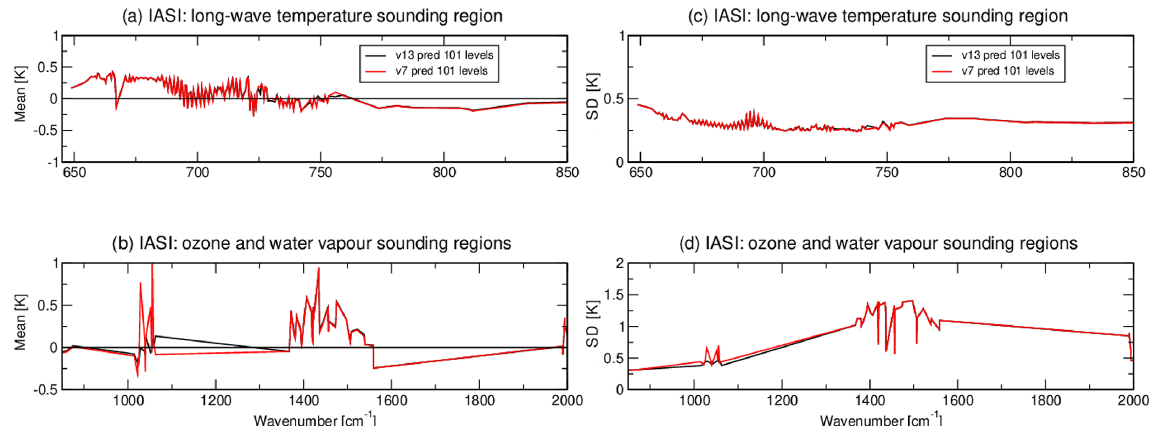
Figure 14. The mean and standard deviation values of the difference between observed and simulated brightness temperatures over the globe for a selection of IASI channels on MetOp-A/B/C in band 1 (a) and band 2 (b) . Calculations are performed with RTTOV v13 with coefficients that are based on the new v13 predictors and the v7 predictors (variable O 3 only on 101 levels).